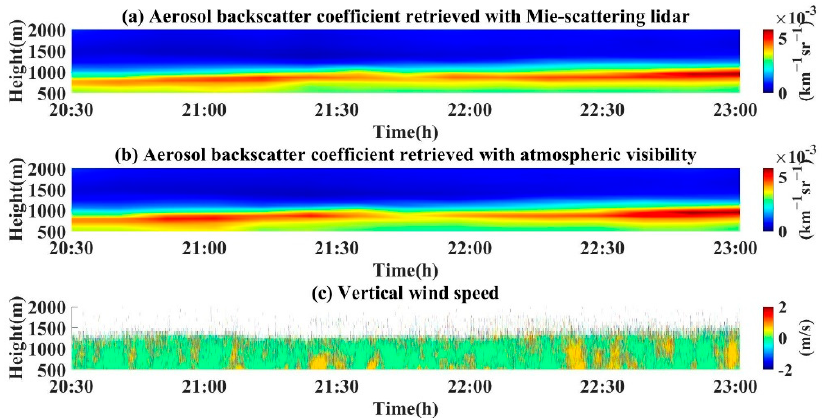
Figure 10. The time–space diagram of joint measurements results on 22 December 2021. ( a ) Aerosol backscatter coefficient at 1550 nm in 10 min and 60 m resolution of the retrieval method with Mie- scattering aerosol lidar, ( b ) aerosol backscatter coefficient at 1550 nm in 10 min and 60 m resolution of the retrieval method with atmospheric visibility, and ( c ) vertical wind speed in 1 s and 60 m resolution of